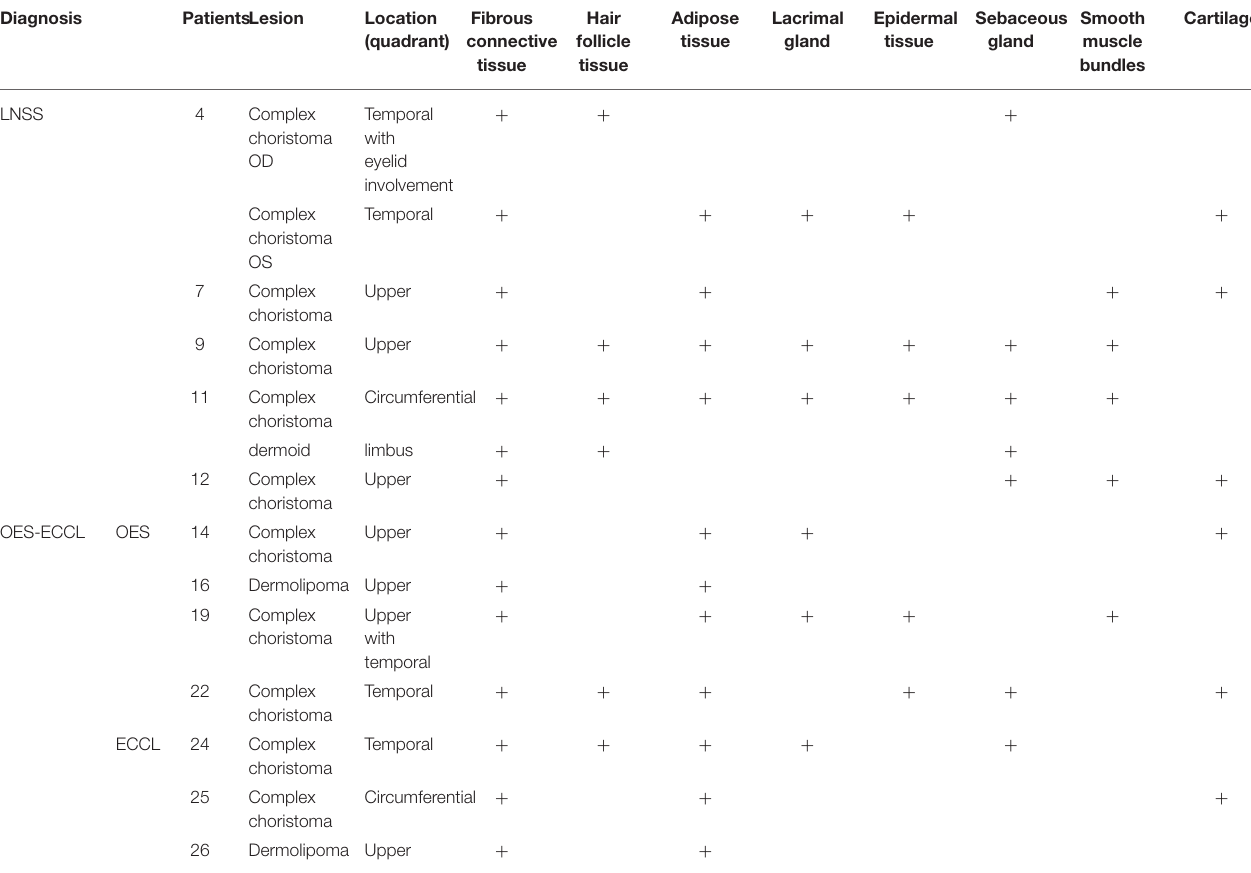
TABLE 3 | Histopathologic features of epibulbar complex choristoma in 12 surgically resected cases.